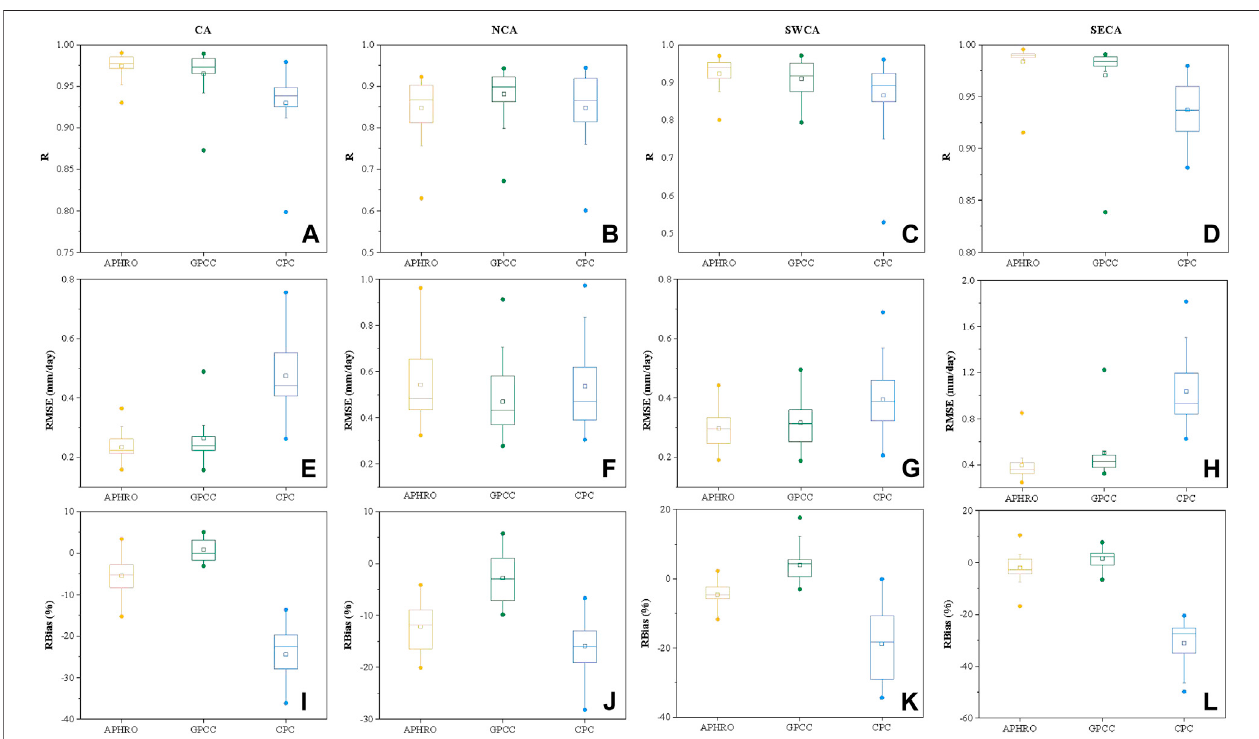
FIGURE 10 | Boxplots of the statistical metrics derive APHRODITE (yellow), GPCC (green) and CPC (blue) daily precipitation from OBS in the CA (A) , (E) , and (I) ; NCA (B) , (F) , and (J) ; SWCA (C) , (G) , and (K) ; SECA (D) , (H) , and (L) . (Two dots in bottom and top for each box represent minimum and maximum value, respectively. Three lines from bottom to top represent 25th percentile, 50th percentile and 75th percentile, respectively. The inside box represent the mean values. ).